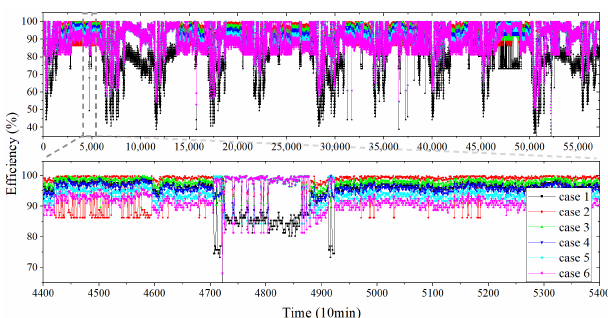
Figure 10. Generator efficiency in each case. Table 6. Generator efficiency in each